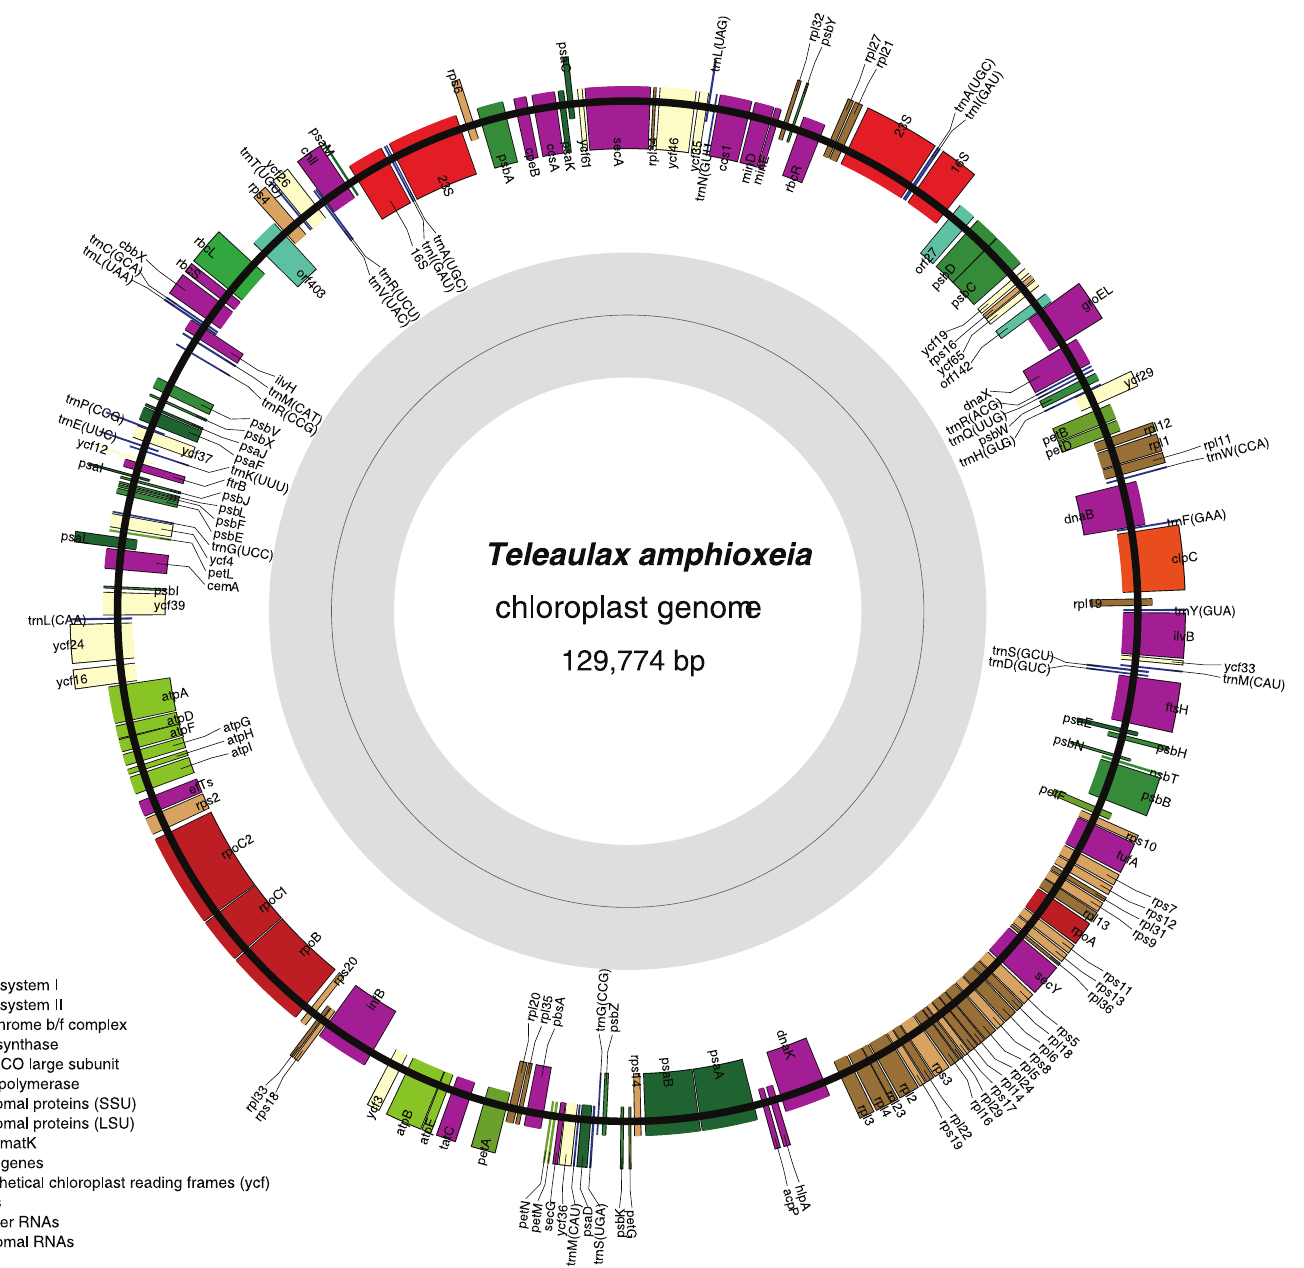
Fig 1. Circular map of the plastid genome of the cryptophyte Teleaulax amphioxeia . All of the genes are transcribed in a clockwise direction. Note the dense gene arrangement and the single large intergenic region. The protein-coding genes and ribosomal RNA and transfer RNA genes are labeled inside or outside of the circle. The genes are color coded according to the functional categories listed in the index below the map.